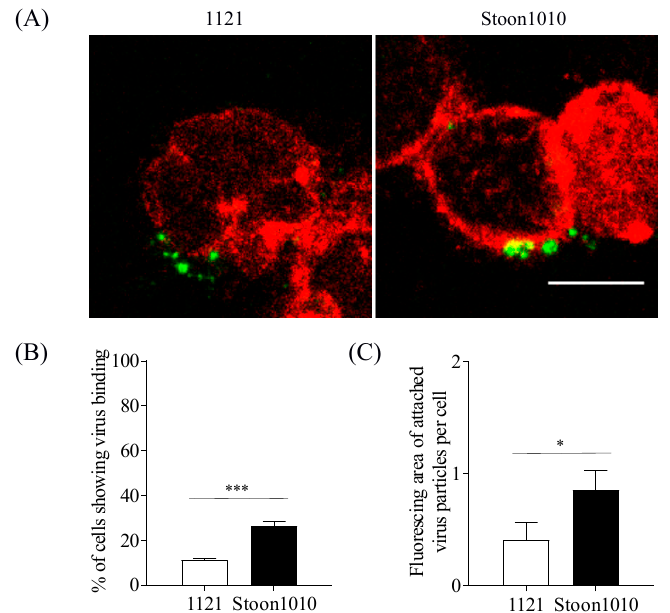
Figure 3. PCV2 attachment to T-lymphoblasts. Cells were incubated with PCV2 particles at 4 ◦ C for 1 h, after which the virus was removed and cells were fixed. PCV2 particles were stained in green, while T-lymphoblasts were stained in red. ( A ) Visualization of PCV2 particles binding to T-lymphoblasts with confocal microscopy. Scale bar = 8 µ m. ( B ) The percentage of T-lymphoblasts showing virus binding was determined. ( C ) The fluorescing area of attached virus particles per cell was quantified with ImageJ. Data represent means ± SD of triplicate assays. * p < 0.05; *** p < 0.001.